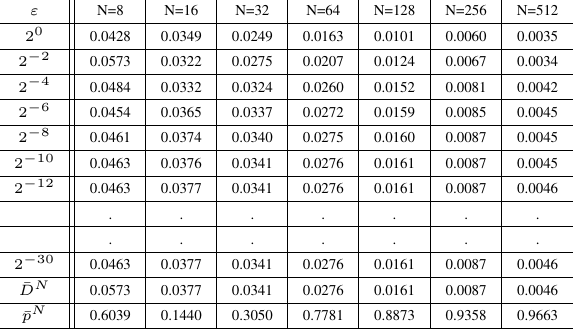
T WO MESH GLOBAL DIFFERENCES ¯ D N ε , PARAMETER - UNIFORM TWO MESH DIFFERENCES ¯ D N AND ORDERS OF PARAMETER - UNIFORM GLOBAL CONVERGENCE ¯ p N FOR THE COMPONENT